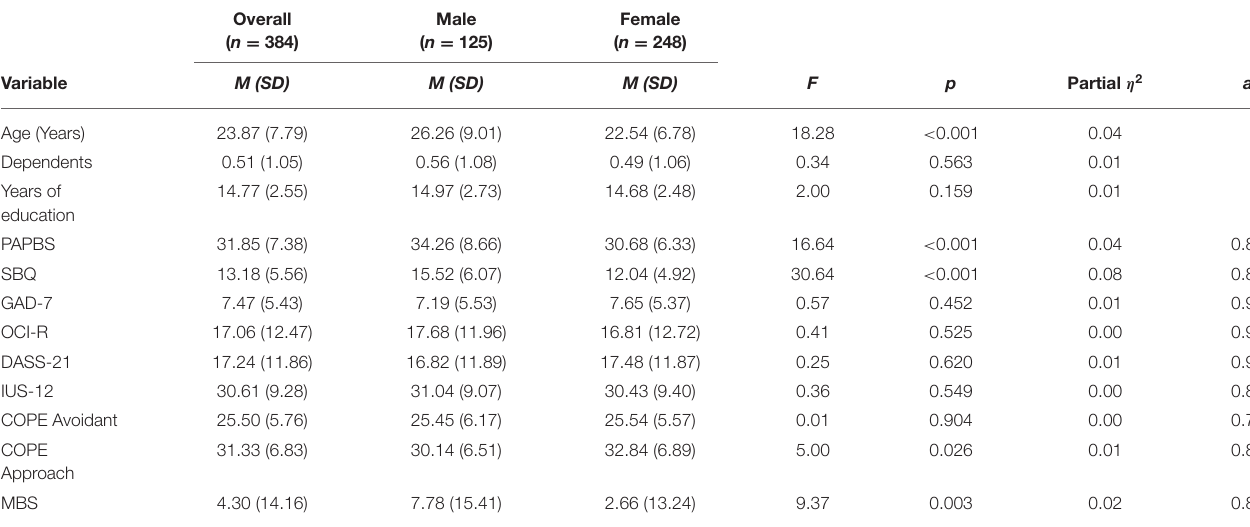
TABLE 1 | Demographic and psychometric variables by gender ( N = 373). Overall ( n =